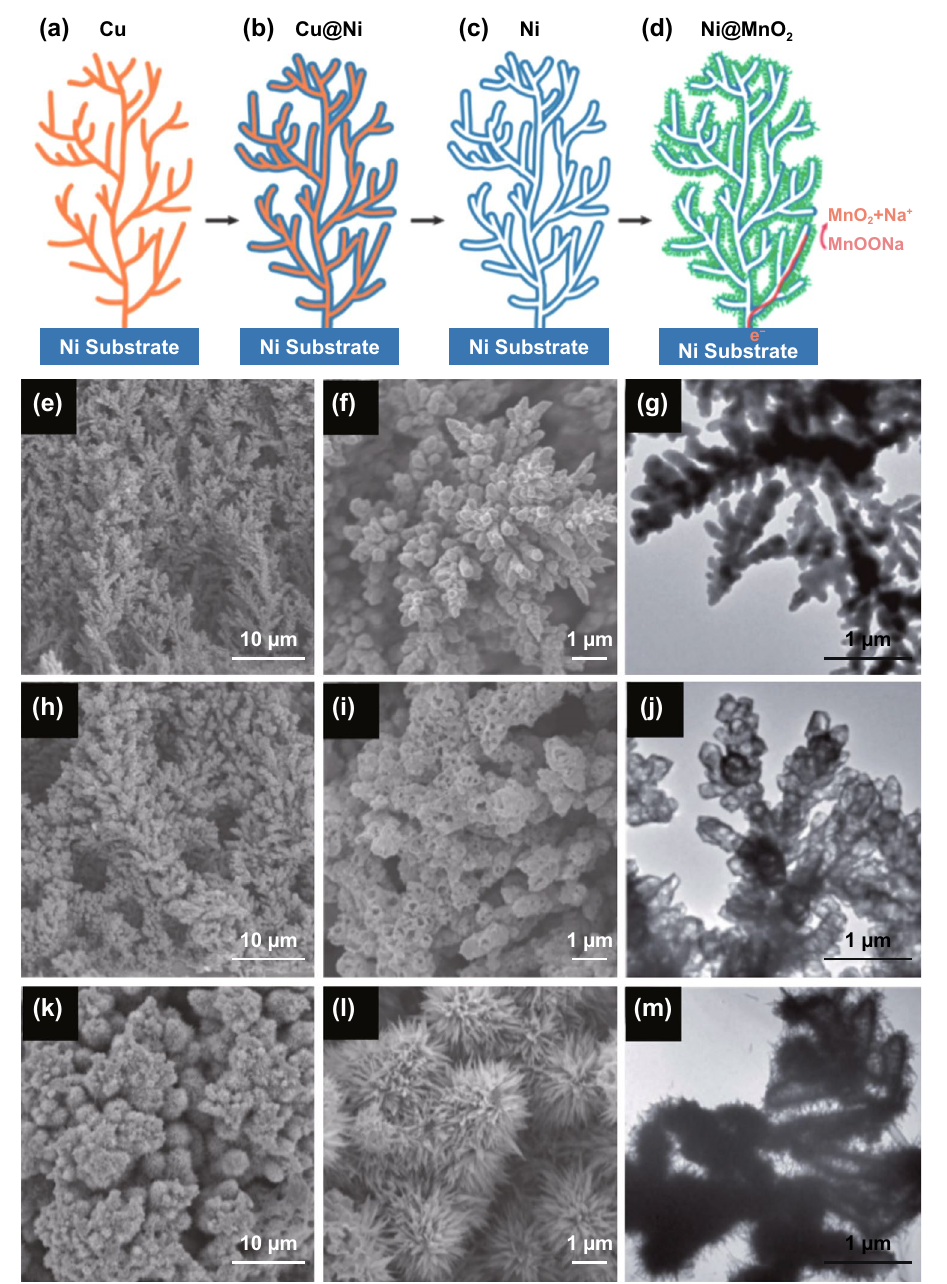
Fig. 15 Synthesis of MnO 2 nanowires supported on hollow Ni dendrites. a Electrodeposition of a nanoforest of Cu dendrites; b electroplating of Ni on Cu dendrites; c selective dissolution of Cu; d electrodeposition of MnO 2 nanowires on hollow Ni dendrites to form a hierarchical Ni@ MnO 2 porous structure. SEM and TEM images of ( e – g ) Cu dendrites, h – j hollow Ni dendrites, and k – m Ni@MnO 2 structure, respectively. Reproduced with permission from Ref. [163]. Copyright 2013, Royal Society of